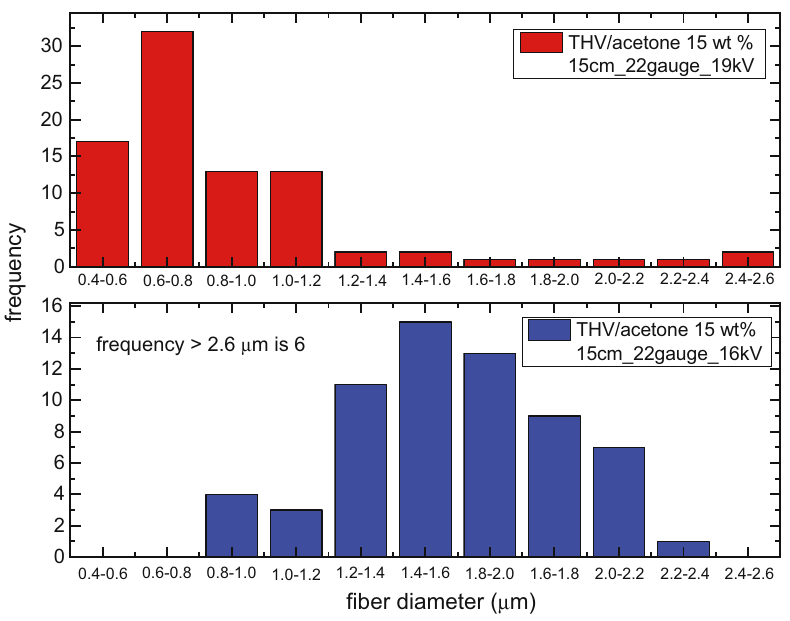
Figure 3: Histogram of fi ber diameter distribution for the fi bers prepared from 15 wt% THV/acetone